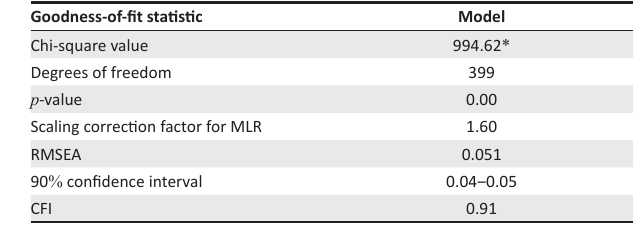
TABLE 1: Goodness-of-fit summary model